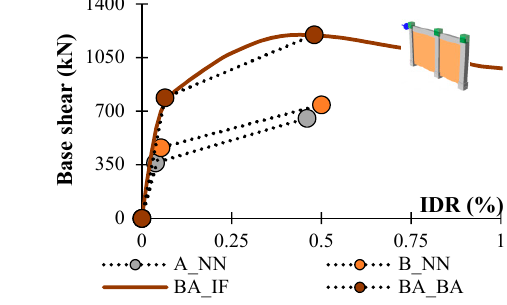
Figure 9. Infilled frame models – multi-bay models with different bay length.